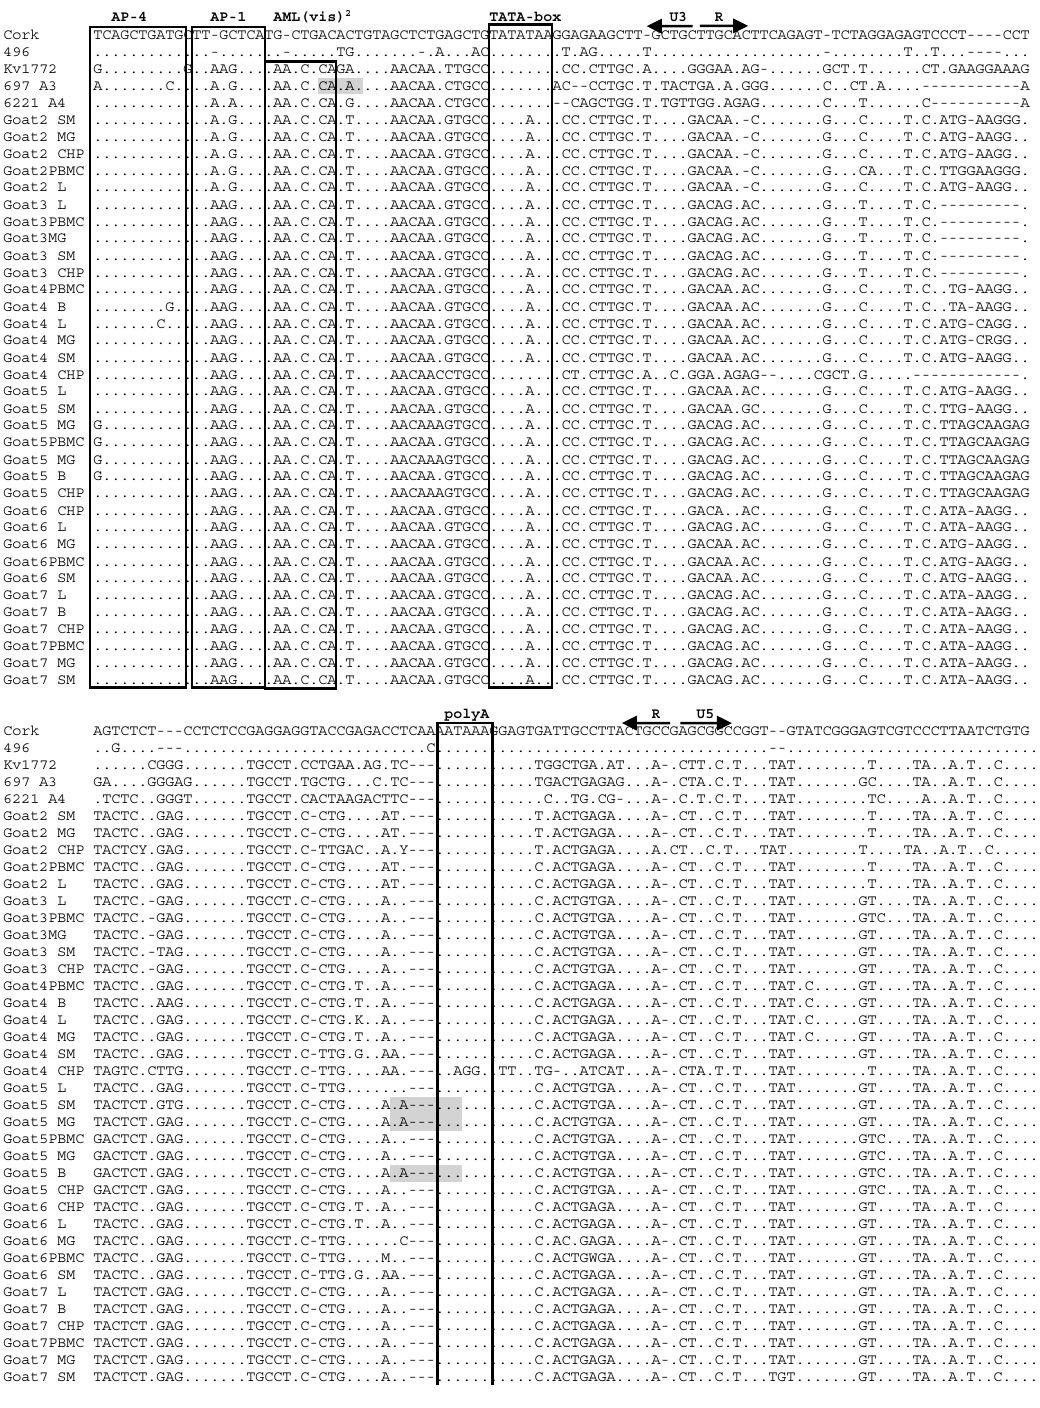
Figure 7. Alignment of U3-R sequences of LTR region from Polish SRLV strains. Sequences are aligned against prototype strains K1514 and Cork representative of SRLV groups A and B, respectively. Dots indicate identity with Cork, and dashes represent gaps. Boundaries between U3, R and U5 are indicated by straight arrows. AP-1, AP-4, AML (vis) motifs, TATA box, GAS, TAS and polyadenylation signal (poly A) are marked by boxes. Gray boxes represent CAAAT sequences. PBMC—Peripheral blood mononuclear cells, L—Lung, SM—Synovial membrane, B—Brain, CHP—Choroid plexus, MG—Mammary gland.